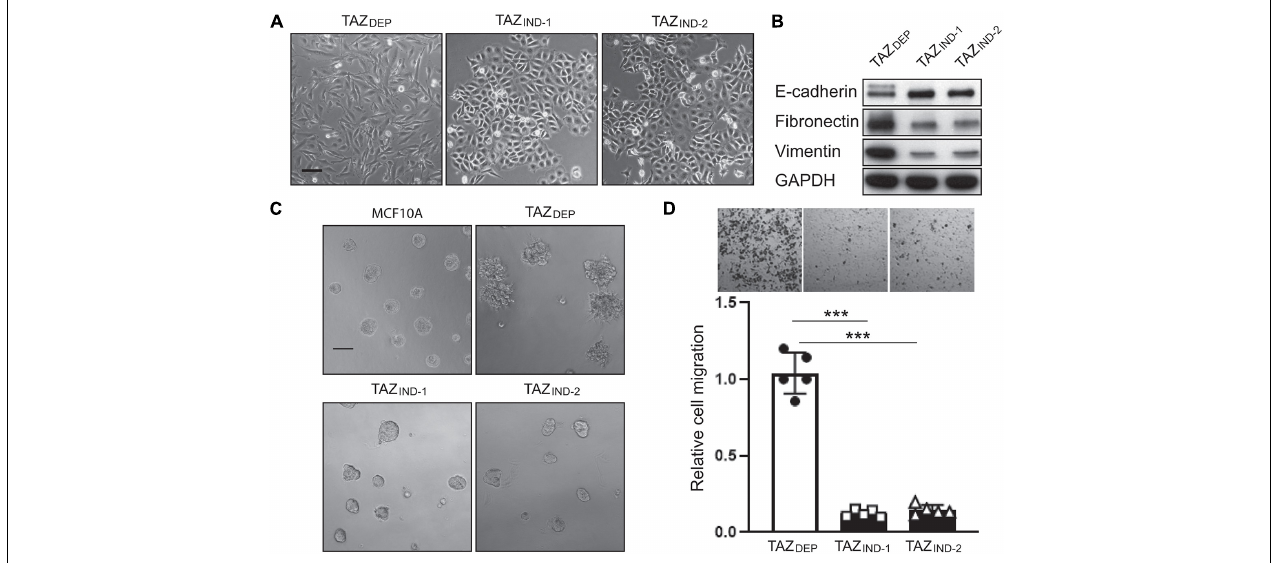
FIGURE 2 | TAZ DEP cells undergo EMT. (A) Representative images of TAZ DEP and TAZ IND cell morphology in a 2D culture. TAZ DEP cells grown in the presence of 2 µ g/ml dox. Scale bar = 50 µ m. (B) Immunoblotting detection of E-cadherin, fibronectin, and vimentin in TAZ DEP and TAZ IND cells. GAPDH was used as a loading control. (C) Representative images of MCF10A, TAZ DEP , and TAZ IND cells grown in a 3D culture. Scale bar = 100 µ m. (D) Representative images and quantification of TAZ DEP and TAZ IND cell migration. Data are shown as the mean ± SD. Unpaired two-tailed Student’s t -test: *** p <